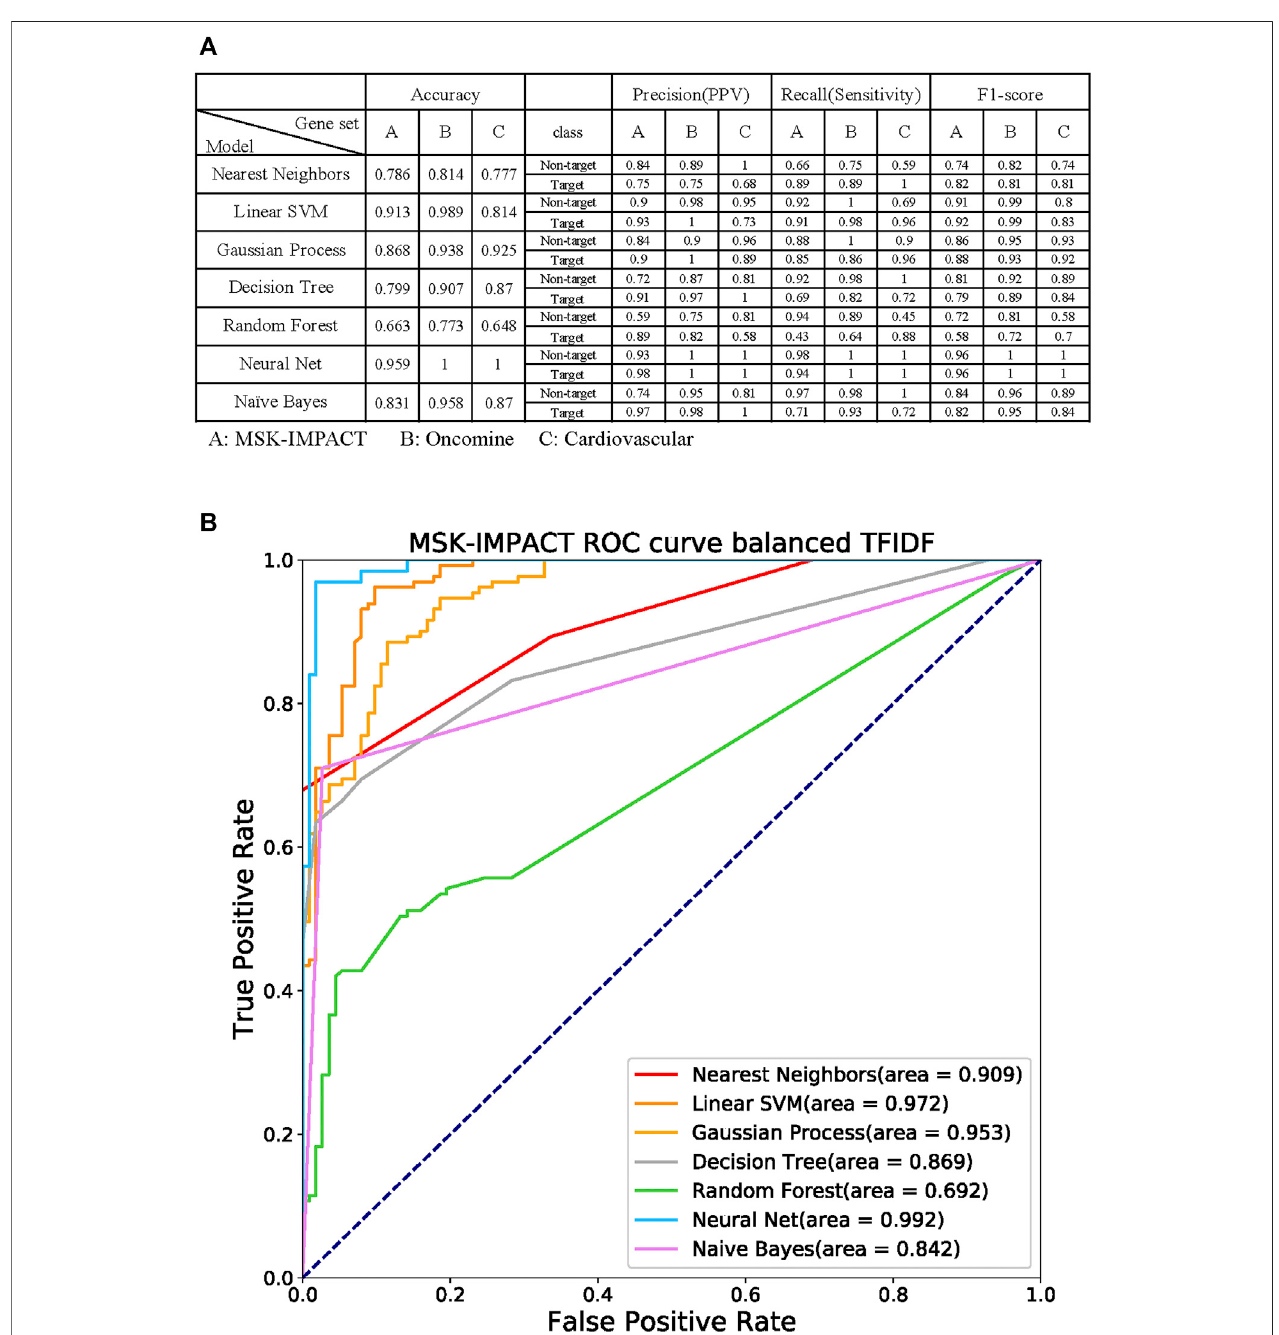
FIGURE6| Performanceofthemachinelearningmodelswiththegenepanel (A) Evaluationoftheoverallaccuracy,precision(positivepredictivevalue,PPV),recall (sensitivity), and F1-score of every prediction model. Each gene could be labeled a target or non-target, indicating whether the gene is in the given target panel. The following seven prediction models were used: nearest neighbors, linear support vector machine (SVM), Gaussian process, decision tree, random forest, neural net, and NaiveBayes.ThetargetgenepanelswereMSK-IMPACT,OncomineComprehensiveAssay,andcardiovasculargenepanels. (B) Receiveroperatingcharacteristic (ROC) curves of the models with the MSK-IMPACT 410-cancer gene panel. The neural net model had the highest area under the ROC curve (AUC), which was 0.992.